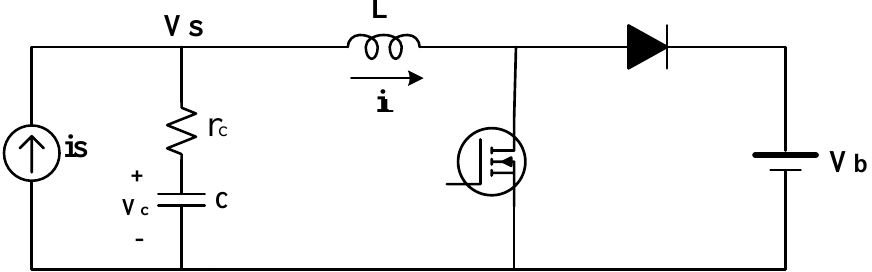
Figure 6. Unterminated model of boost converter with input as the current source.